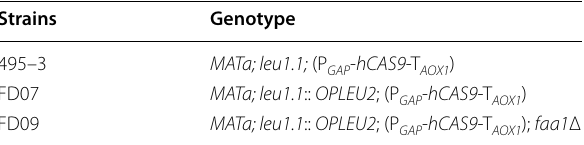
Table 1 Strains used in this study Strains